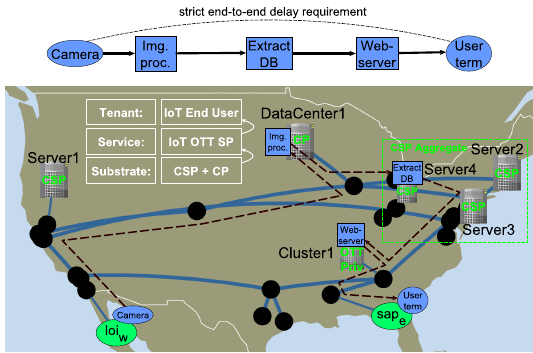
Figure 1. Demonstration of a wide area network with heterogeneous computation components with multiple stakeholders: Communication Service Provider (CSP) and Cloud Provider (CP) selling infrastructure to Over-the-Top Service Provider (OTT SP), who provide remote security camera analytics and alerts Internet of Things (IoT) services to its